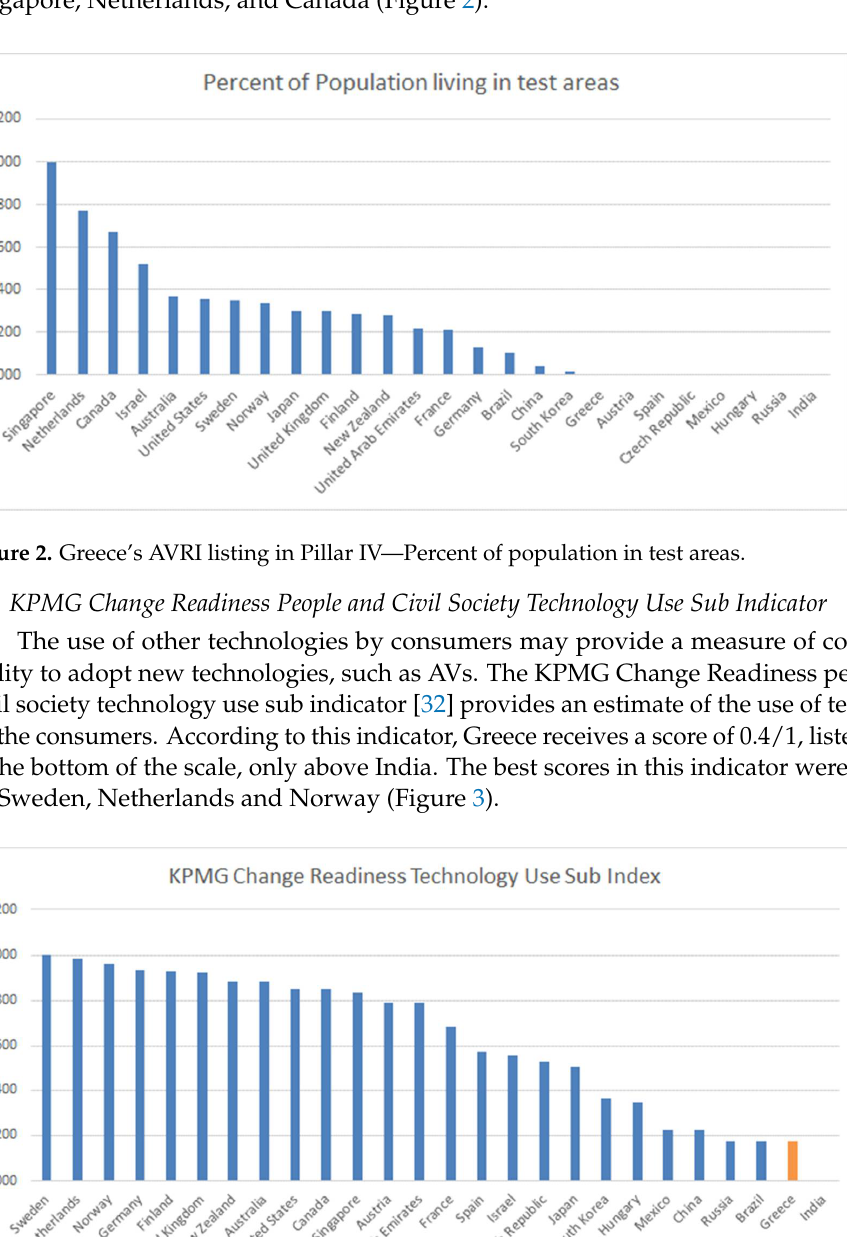
Figure 1. Greece’s AVRI listing in Pillar IV—Consumer opinions.